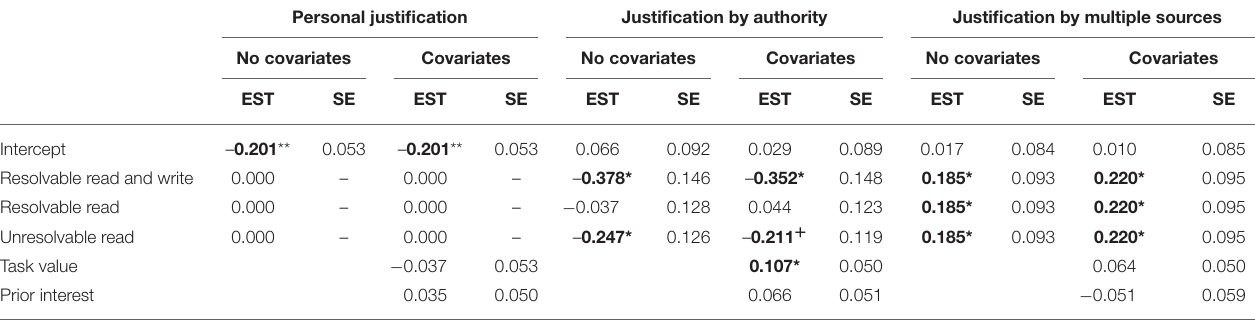
TABLE 9 | Regression coefficients of target models predicting epistemic change in justification